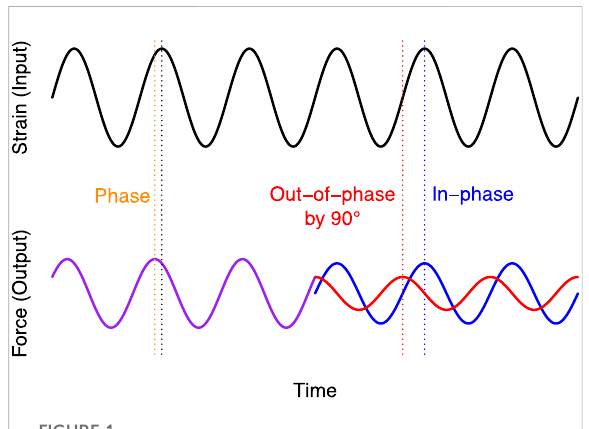
FIGURE 1 Exploited practicalities of the sine wave in oscillometry. The sine wave on top (black) is the input signal; i.e. , the one controlled bytheexperimenter. Forexample,thestrain(in mm)on anexcised strip of lung tissue. The purple line on the bottom left is the output signal; i.e. , the one measured by the experimenter. In this example, the output signal would be the force (in mN). Note that the sine wave shape and the frequency of the oscillation were preserved from the input to the output ( i.e. , the black and purple lines are sine waves at the same frequency). However, the output sine wave has changed in amplitude and phase (orange) in relation to the input. These are convenient practicalities of the sine wave that pertain as long as the material being investigated behaves linearly. It means that the response of a linear system to a sinusoidaloscillationissimplycharacterizedbymeasuringhowthe sine wave amplitude and phase are changing from the input to the output. Another convenient practicality of the sine wave is that by addingtwosinewavesofidenticalfrequencytogether,theresultis always another sine wave at the same frequency. Based on the same reasoning, the output in purple may originate from two sine waves, as shown in blue and red on the bottom right. Note that these two sine waves are again at the same frequency. Also note thatwhile thebluewassettobein-phasewiththeinputsignal ( i.e. , strain),theredwassetto beout-of-phasefromtheblue,aswellas the input signal, by exactly 90 ° . The red sine wave is thus a cosine wave. Importantly, when the strain rate ( i.e. , the fi rst derivative of strain) is calculated from the input signal, the amplitude of this rate over time would follow a sine wave in-phase with the red line. The strain and the strain rate are thus out-of-phase by exactly 90 ° whenthestrainfollowstheformofasinewave.Asdiscussedinthe text, the elastic and resistive forces emanating from the tissue during sinusoidalstraining arealso in-phasewiththestrainandthe strain rate, respectively. Therefore, dividing a sinusoidal output signal(purple)intoacomponentin-phasewiththeinput(blue)and another component 90 ° out-of-phase with the input (red) is an easy trick that simultaneously separates the respectively contribution of elastance and resistance. Essentially, it means that the forces attributed to elastance and resistance over time are described by the blue and red lines,